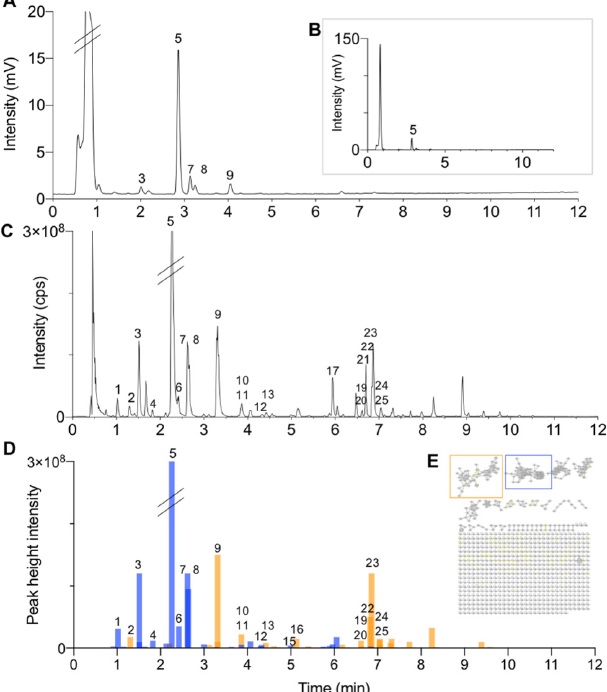
Figure 1. Metabolite profiling of PLRE: ( A , B ) UHPLC-ELSD chromatogram highlighting the main constituents of PLRE, ( C ) UHPLC-HRMS/MS chromatogram in ESI positive ionization, and ( D ) bar chromatogram of the peaks detected in two distinct clusters in the FBMN ( E ). ( E ) FBMN of the metabolite profiling of PLRE. In ( D , E ), in blue, the peaks of the cluster containing the C -glycoside isoflavone puerarin ( 5 ) and linked peaks; in orange, the peaks of the cluster containing isoflavone O -glycosides and aglycones, including daidzin ( 9 ), genistin ( 16 ), daidzein ( 23 ), and genistein ( 28 ). See Tables 1–4 for annotations and Supplementary Material Section S1, Figure S1 for the full FBMN. Since PL is a widely used medicinal herb whose composition has been well docu- mented [43], an annotation strategy was performed first. The main NP was annotated as puerarin ( 5 ), a predominant C -glucoside isoflavone described for PL [43] (Tables 1 and 3 and Figure 1). Another main constituent was annotated as daidzin ( 9 ), an O-glucoside sharing the same aglycone as puerarin (daidzein ( 23 )) (Tables 2 and 4). Nine additional C- glycosides ( 1 , 3 , 4 , 6 , 7 , 8 , 11 , 12 , 15 ) and nine O-glycosides ( 2 , 10 , 13 , 16 , 17 , 19 , 20 , 22 , 25 ) were annotated from these two classes of glycosides, of which 3 , 7 , 8 were clearly detected by ELSD (Figure 1C,D and Tables 1, 3, and 4). Thus, the five secondary metabolites de- tected by ELSD were all isoflavone glycosides, which is logical since the extraction was obtained by decoction. Two puerosides were additionally annotated ( 14 , 21 ) (Table 1). Fi- nally, the corresponding aglycones, mainly daidzein ( 23 ), were detected (Tables 1 and 2). Among these annotations, five were compared with commercial standards, allowing their unambiguous identification (puerarin ( 5 ), daidzin ( 9 ), genistin ( 16 ), daidzein ( 23 ), and genistein ( 28 )).